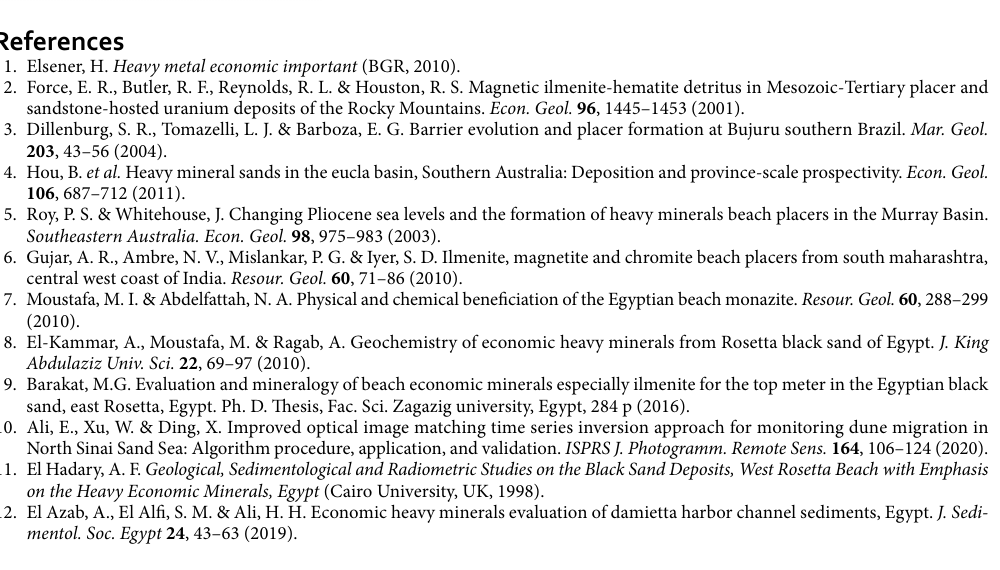
Economic heavy minerals % The average